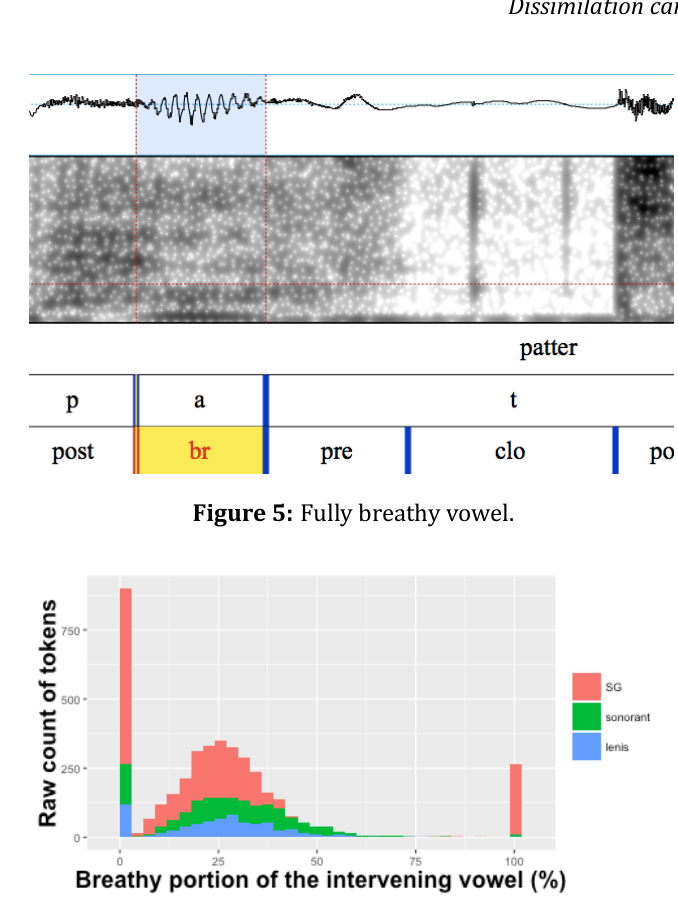
Figure 6: Breathy proportion of the intervening vowel (as a percentage of vowel dura- tion) depending on the type of